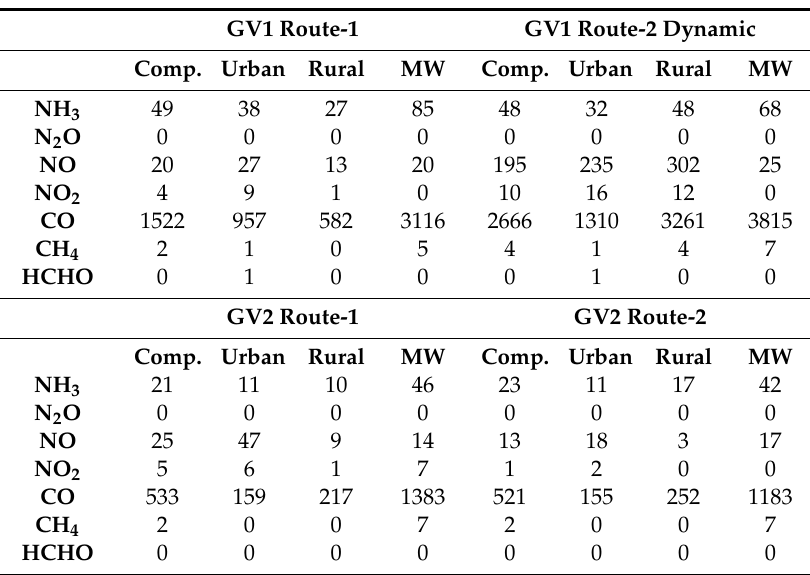
Table 3. NH 3 , N 2 O, NO, NO 2 , CO, CH 4 , and HCHO emissions factors (mg / km) obtained for the GV1 and the GV2 during the two tests performed for each vehicle along Route-1 and Route-2. The GV1 was tested on a dynamic driving on Route-2. Emission factors (mg / km) are presented for the complete routes (Comp.), and the urban, rural and motorway (MW)